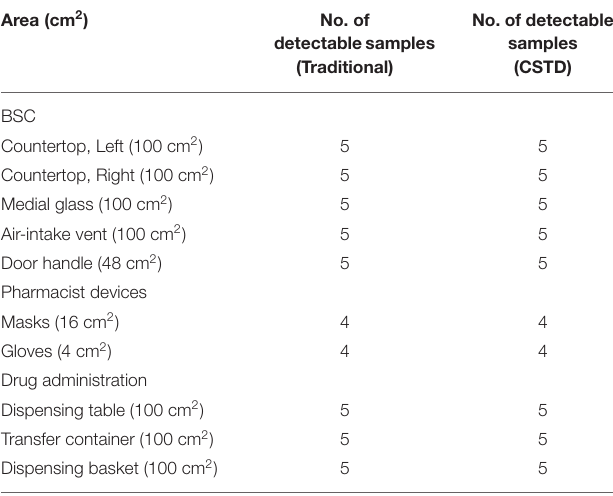
TABLE 2 | Summaries of wiping samples for traditional and closed system transfer device (CSTD) systems. Area (cm 2